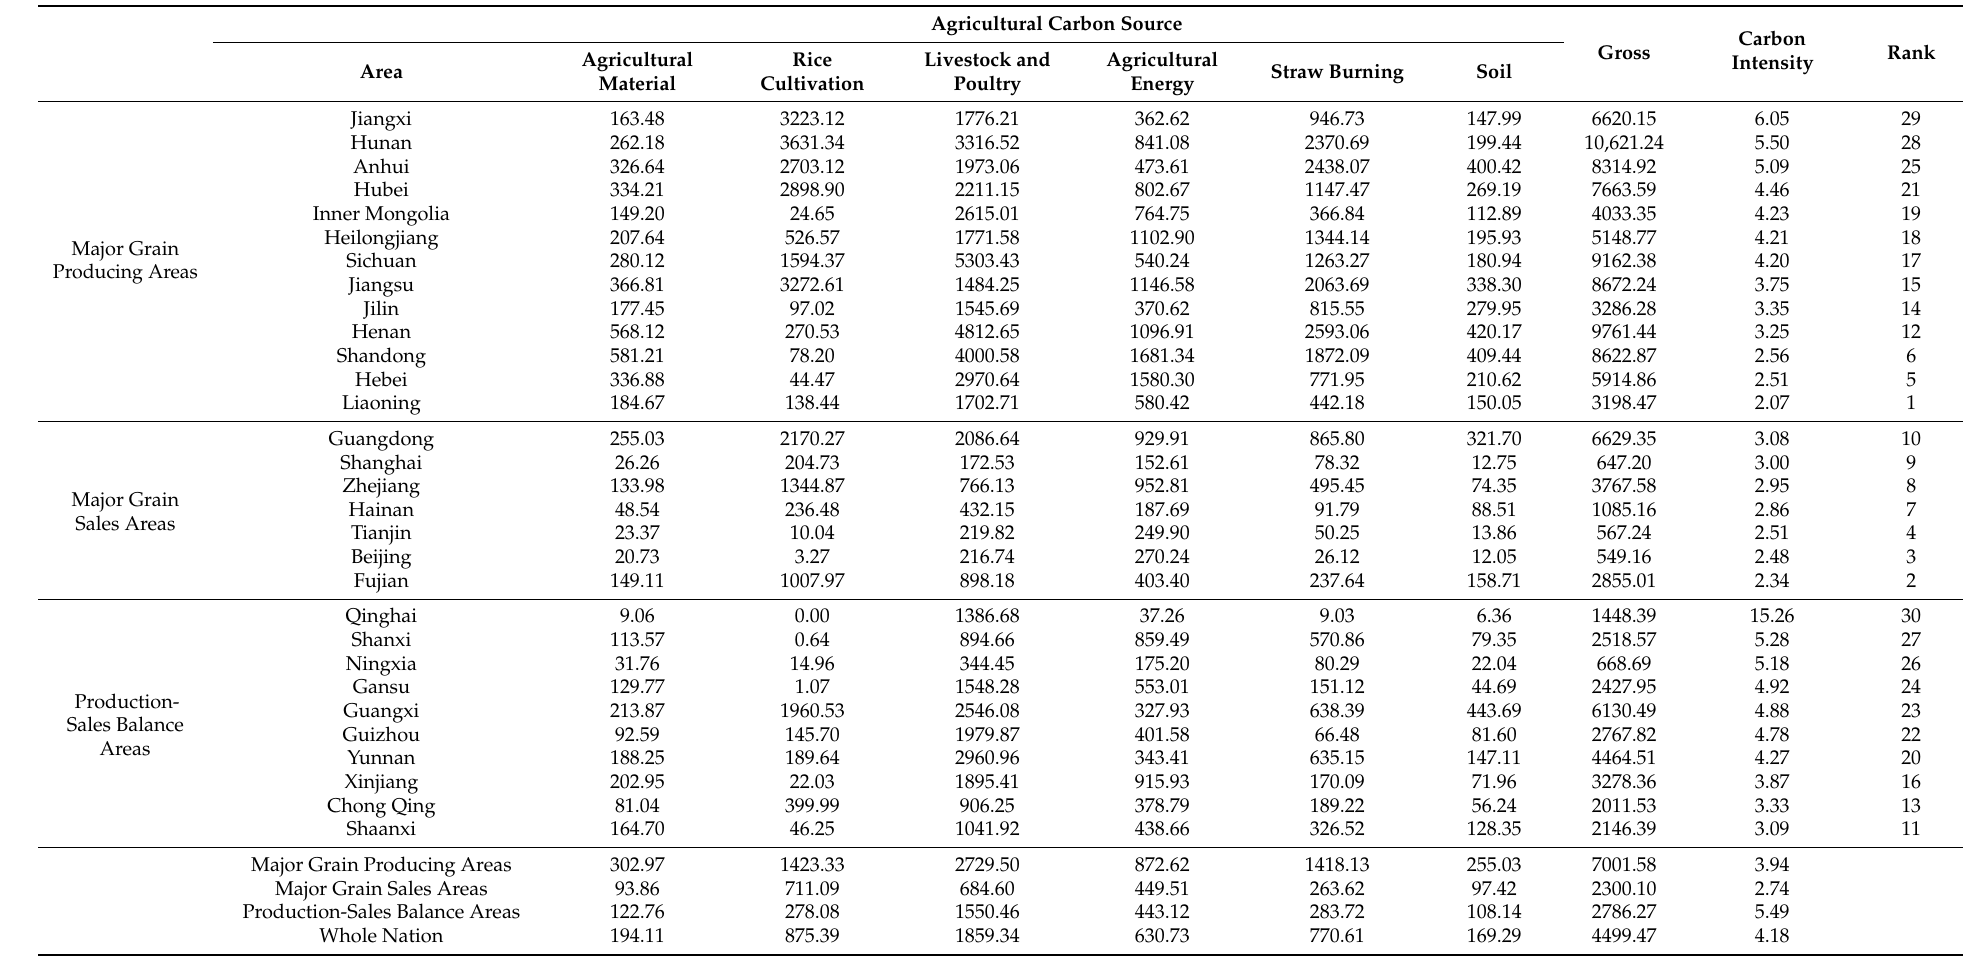
Table 2. Annual agricultural carbon emissions in